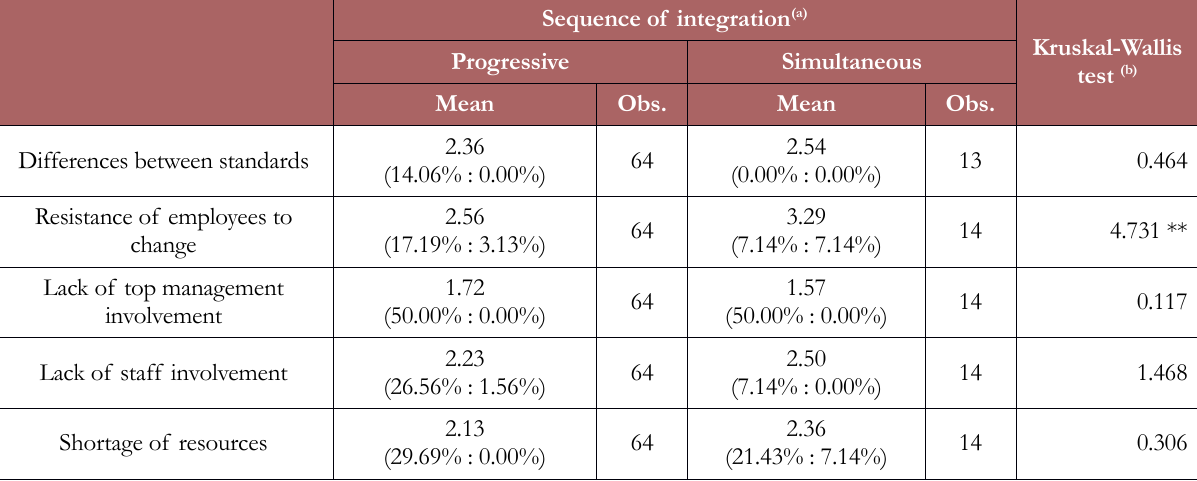
Table 1. Kruskal-Wallis test: Difficulties according to the sequence of